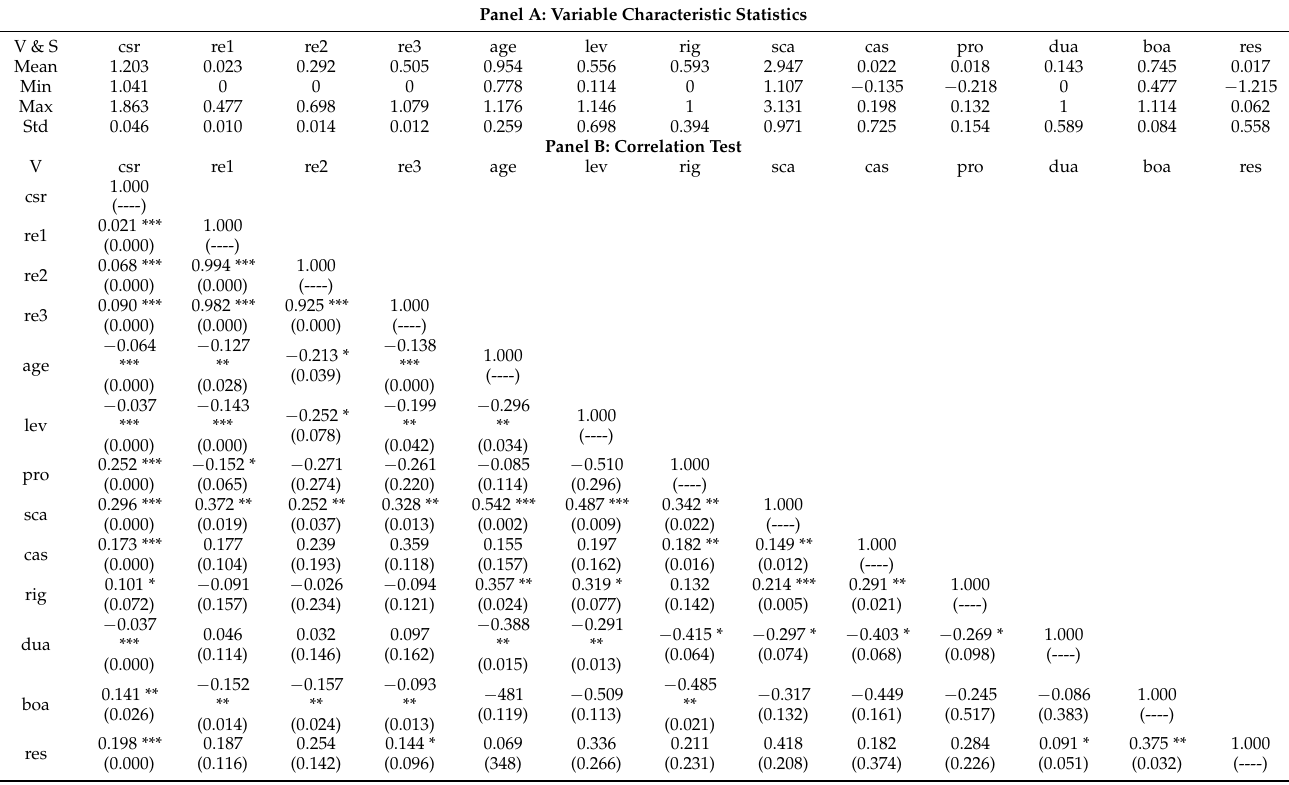
Table 2. Results of analysis of basic statistics. Panel A: Variable Characteristic